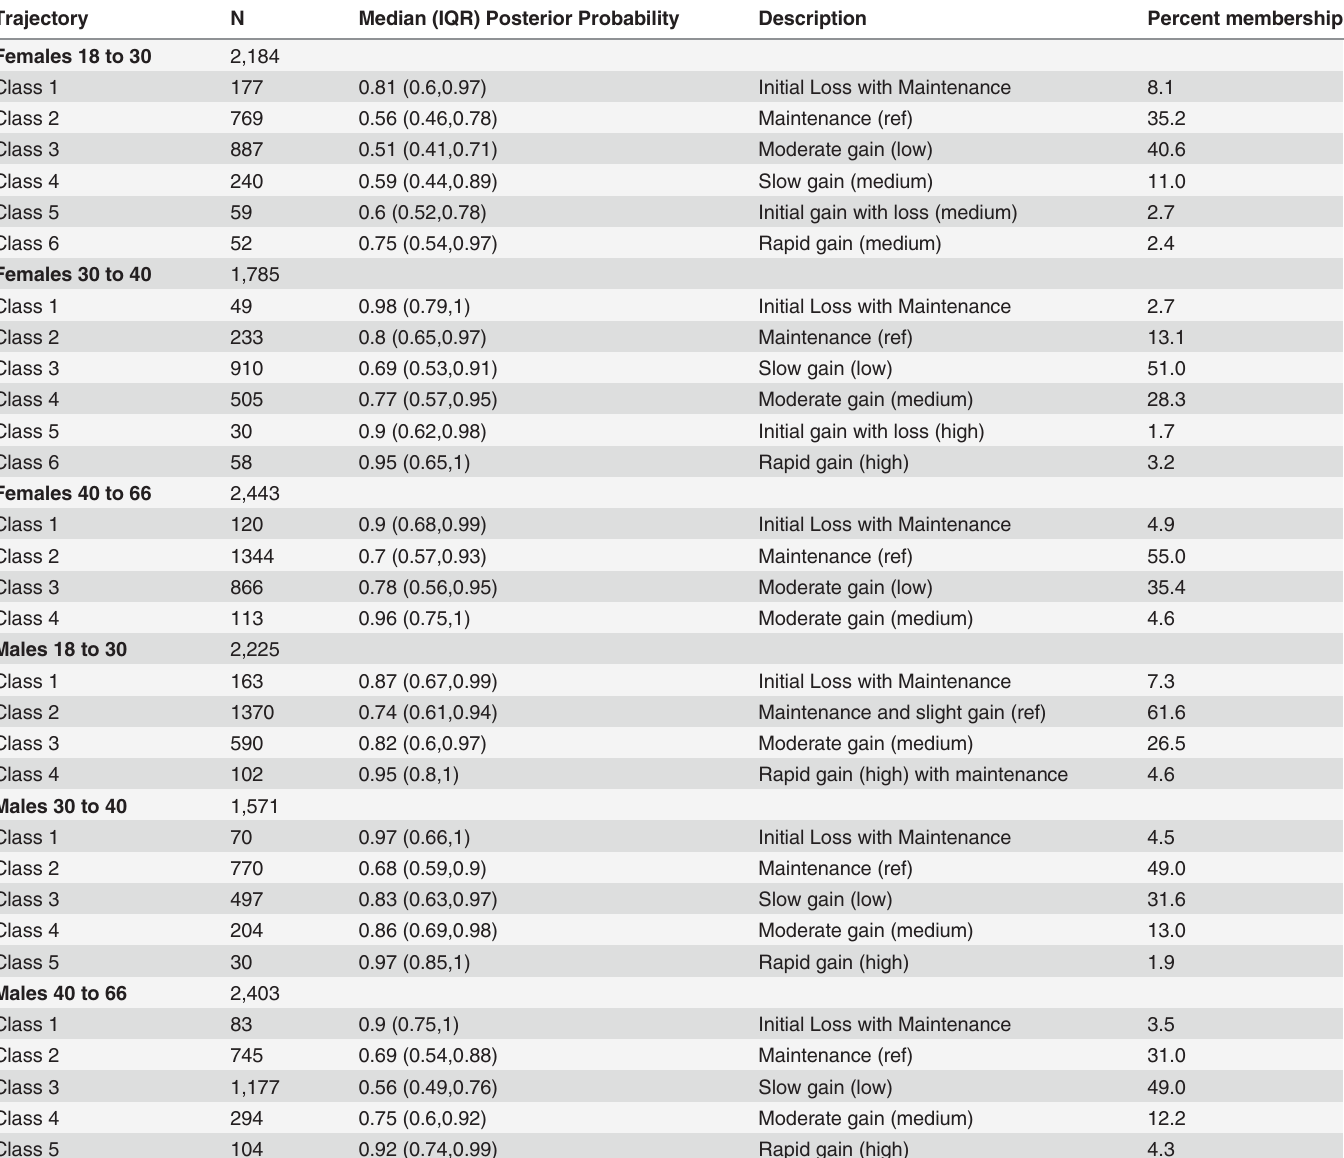
Table 2. Trajectory Descriptions, Median Posterior Probabilities and Group Membership Percentage, China Health and Nutrition Survey * . Trajectory N Median (IQR) Posterior Probability